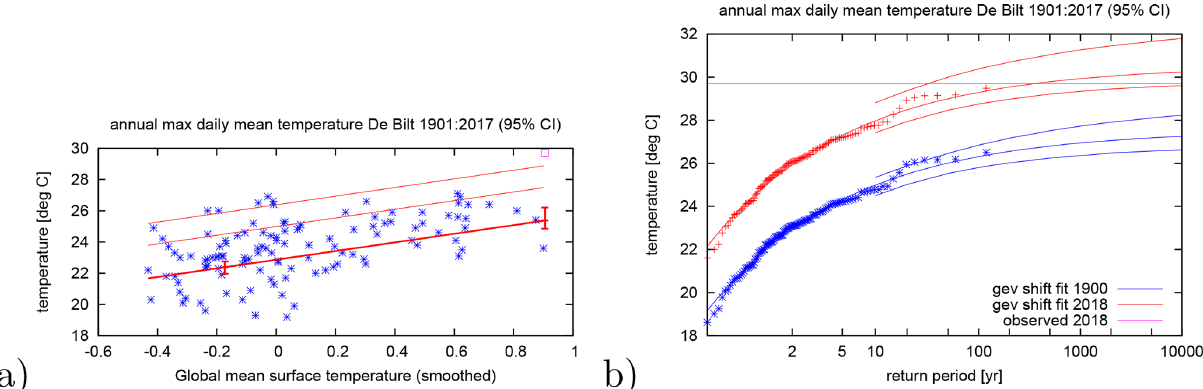
Figure 5. Fit of a GEV of the highest daily mean temperature of the year at De Bilt, the Netherlands, for 1901–2017, shifting with the smoothed GMST, with the value for 2018 (29.7 ◦ C) in purple. (a) As a function of GMST, the thick lines denote µ , the thin lines the 6- and 40-year return periods. (b) As a function of return period in the climate of 1900 (blue) and 2018 (red). After van Oldenborgh (2018).